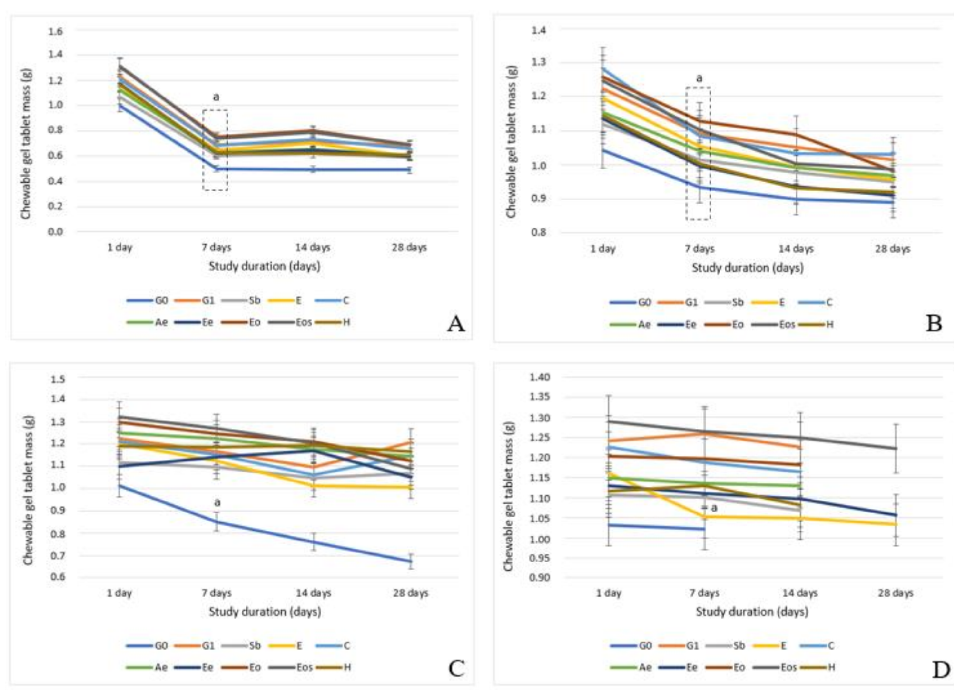
Figure 2. Chewable gel tablets’ mass variation: ( A ) in an open plastic bag at room temperature (OR); ( B ) in a plastic box in a freezer (PBF); ( C ) in a plastic box in a refrigerator (PBR); ( D ) in a squeezable plastic bag at room temperature (BR), the expired curve in ( D ) shows that the tablets became moldy and were not weighed; n = 8; a— p < 0.05 vs. mass after 1 day. All samples’ tablets (Figure 2A) weighed from 1.001